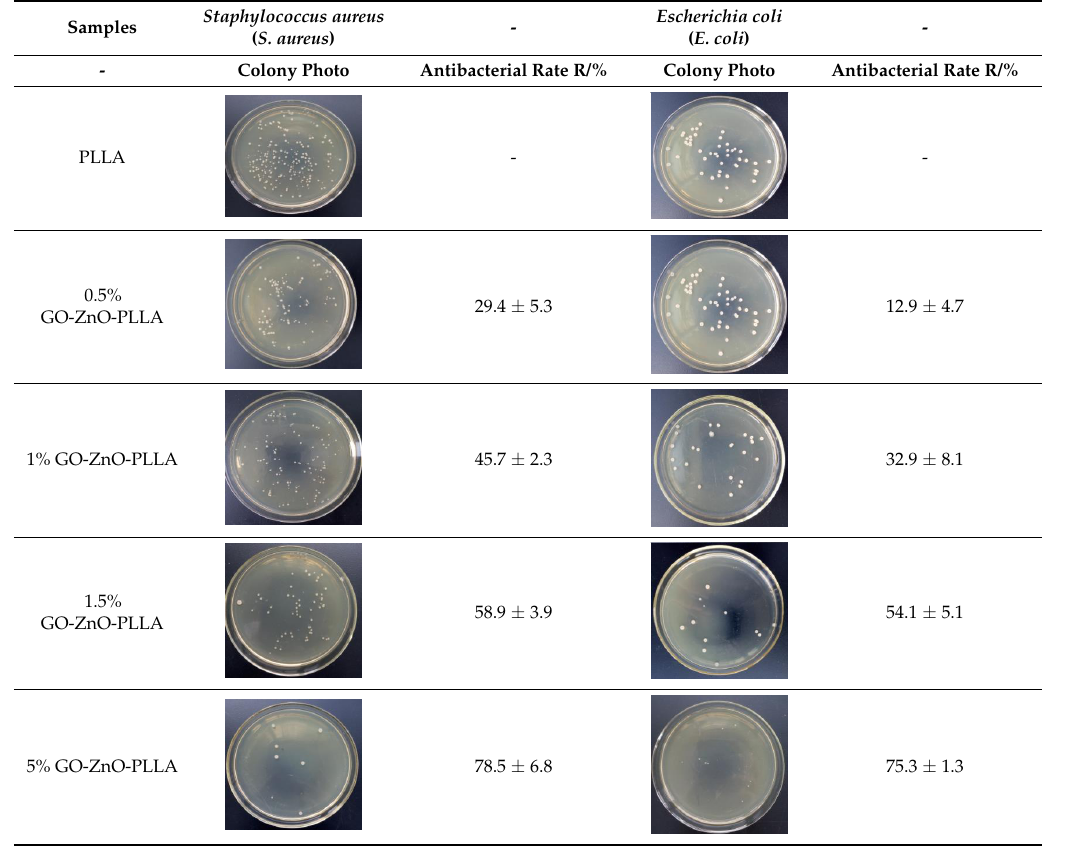
Table 3. Test results of the antibacterial properties of GO-ZnO-PLLA/PLLA composite film under light exposure. Samples